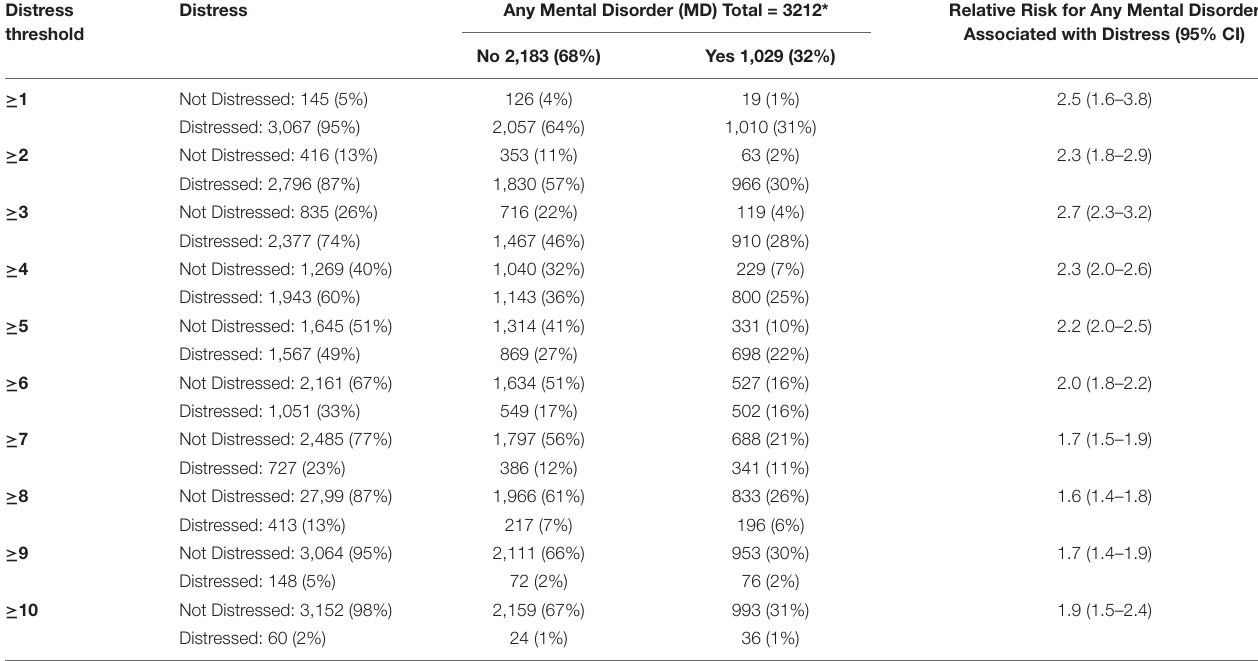
TABLE 2 | Co-occurrence of distress cases with MD cases for increasing distress